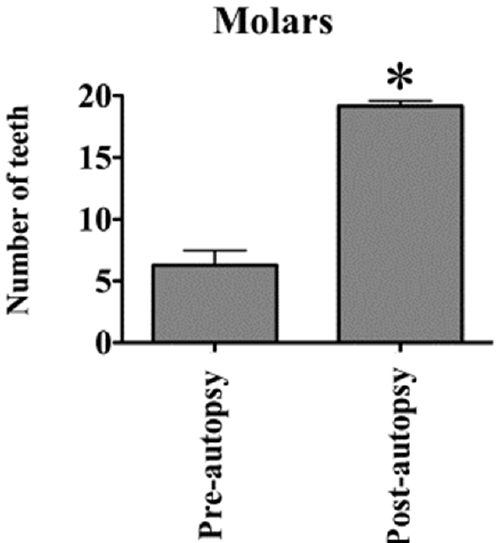
Figure 2. Differences in the number of molars examined in the pre- and post-autopsy groups. The number of molars is compared between the pre- and post-autopsy groups, in the 30 bodies from which dental findings were obtained before and after autopsy. The mean number of molars is 6.3 and 19.2 before and after the autopsy, respectively. The number of molars is significantly higher in the post-autopsy group than in the pre-autopsy group (* p < 0.05 vs. the pre-autopsy group; n = 30; the values are presented as the mean ± the standard error).